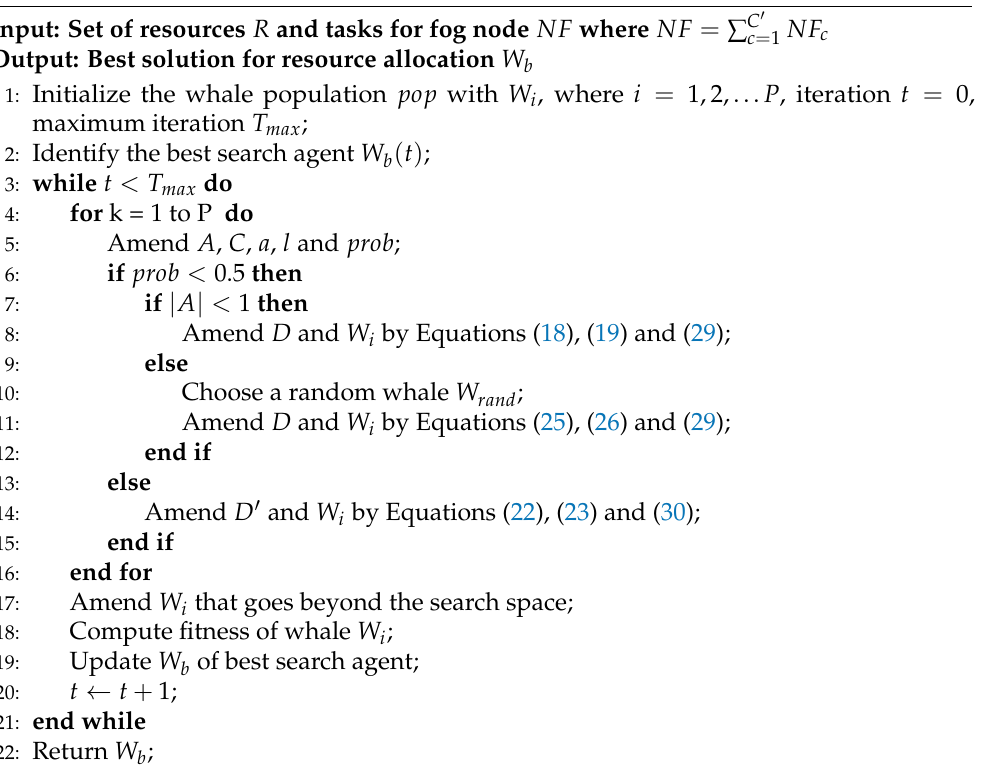
Algorithm 4 Whale optimized resource allocation (WORA)